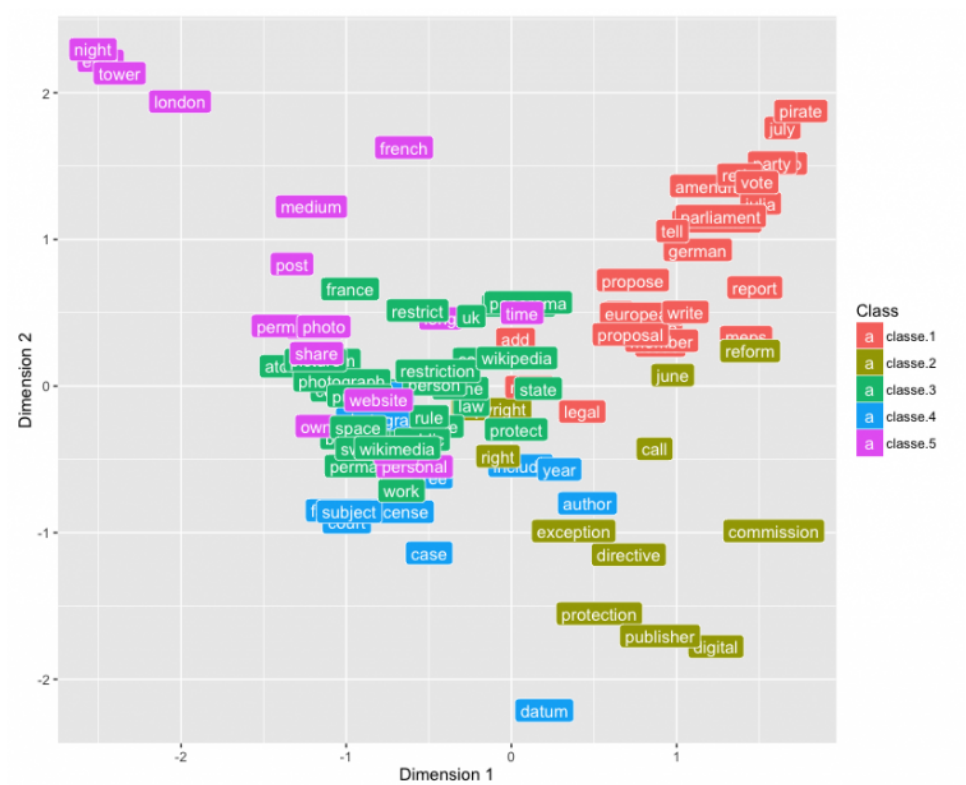
Figure 6: Words and media correspondence in the English corpus.